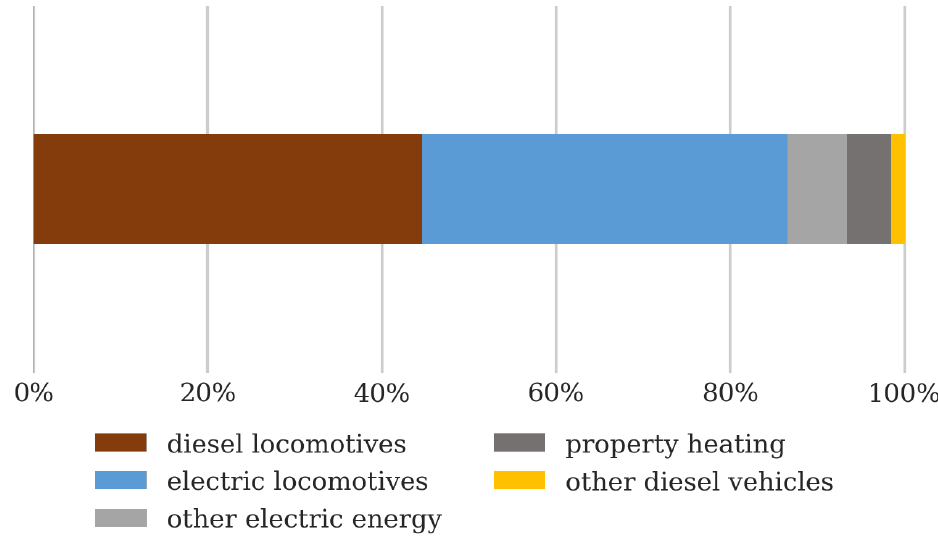
Figure 9. Structure of energy use in DB Cargo Polska in 2020. Own study based on company